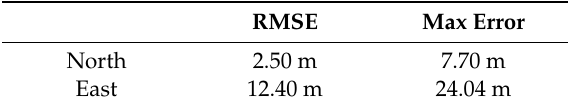
Figure 15. Air-Odo/vehicle dynamic model/INS integration performance during 125 seconds of complete GNSS signal outage.